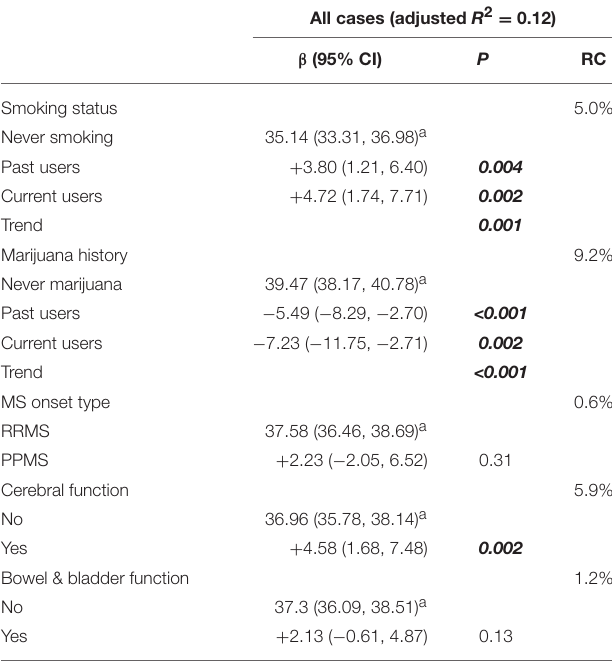
TABLE 5 | Mutually adjusted model including all factors associated with age of symptom onset. All cases (adjusted R 2 =